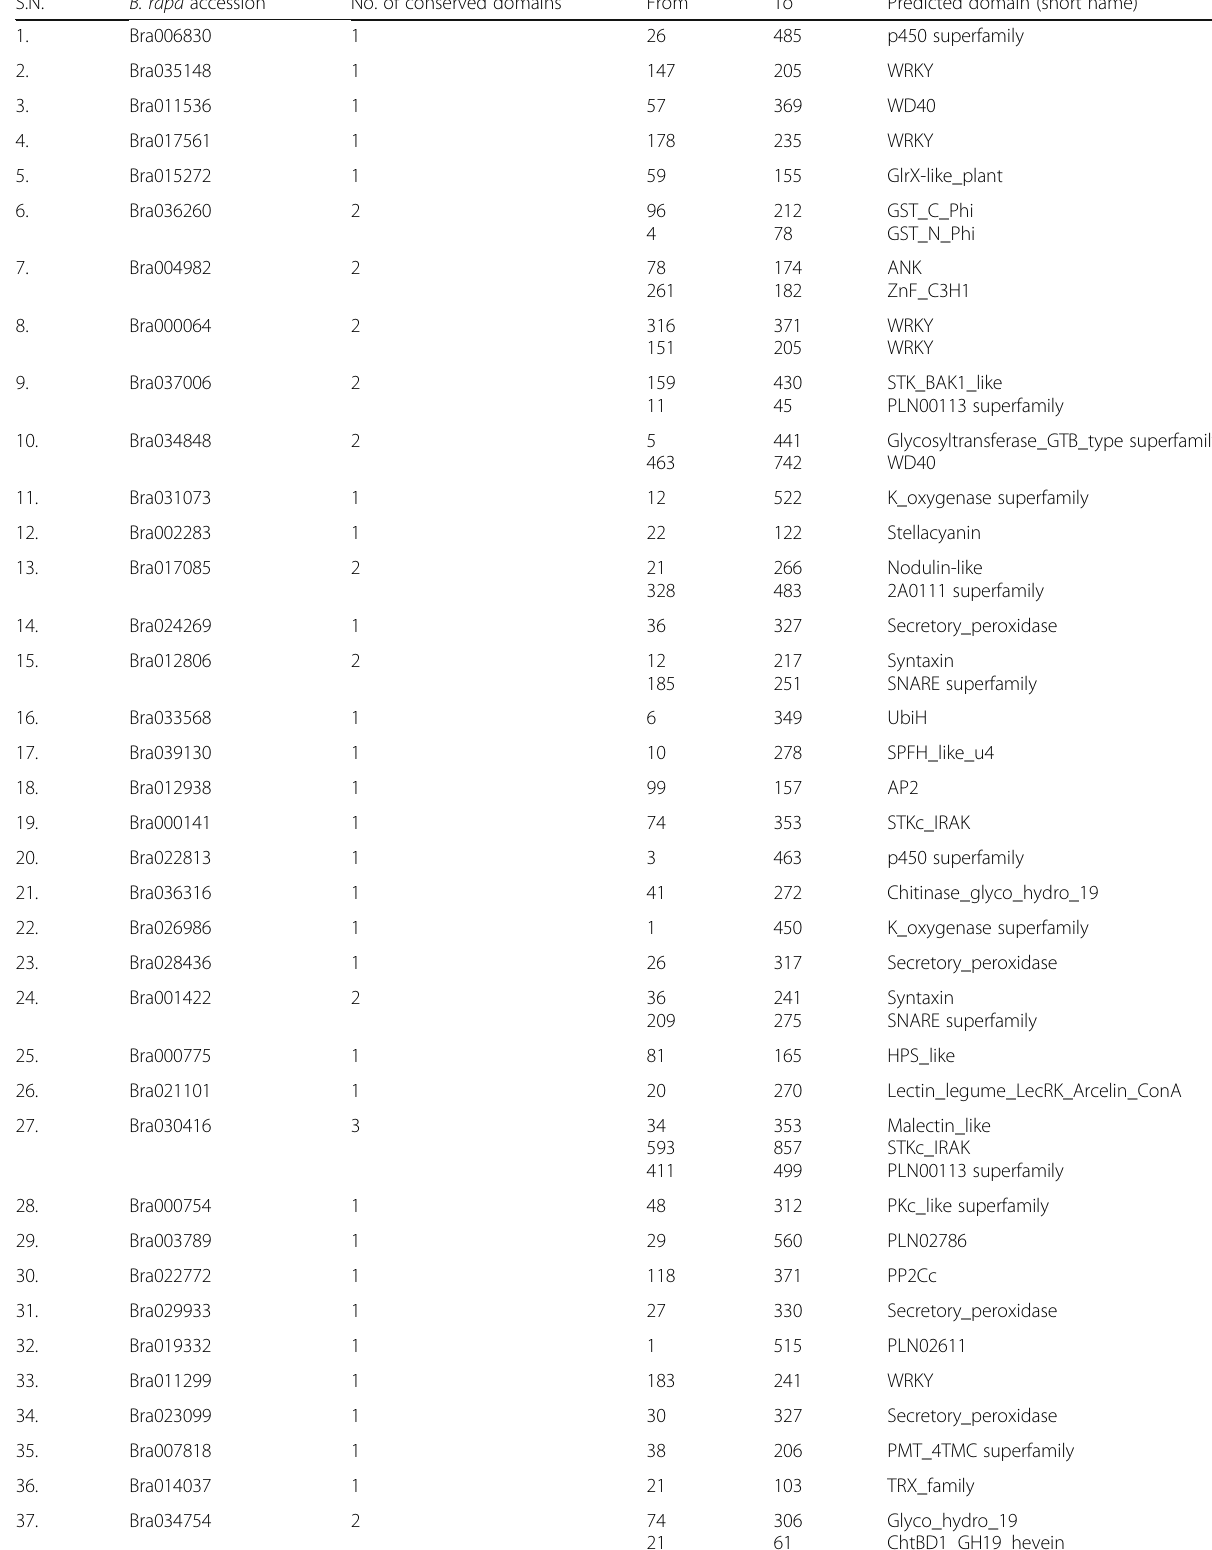
Table 3 Predicted conserved domains in identified up-regulated Brassica rapa sequences with their positions under contrast JAMC